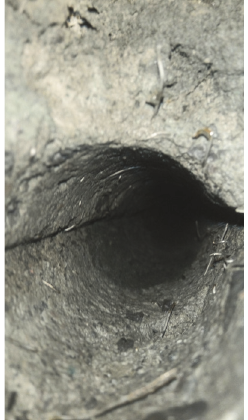
Figure 3: Grooved blast